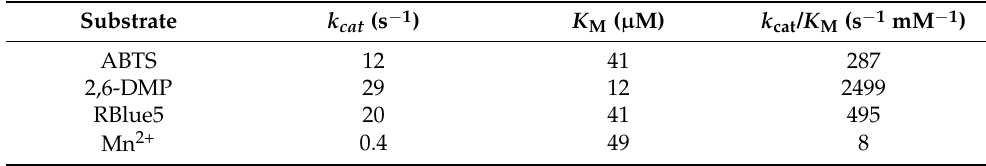
Table 2. Apparent kinetic constants ( K M , k cat , and k cat / K M ) of purified Xgr DyP for the substrates ABTS, 2,6-DMP, RBlue5, and Mn 2+